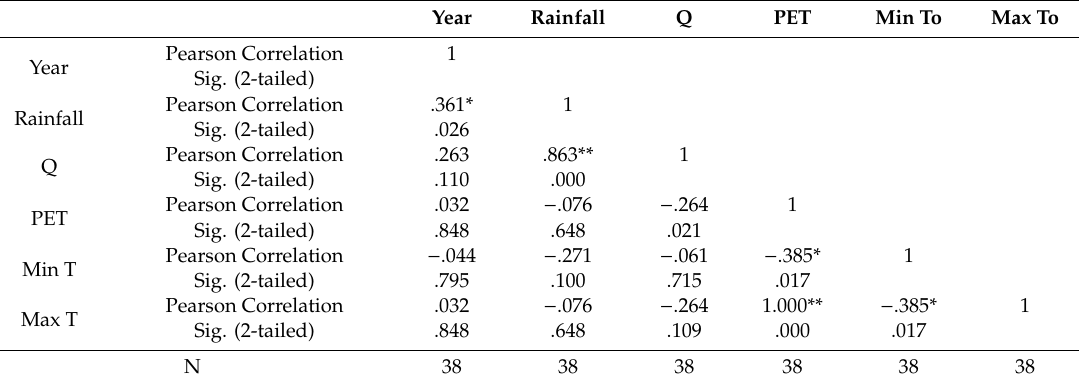
Table 7. Pearson’s coe ffi cient of correlation between discharge and climatic